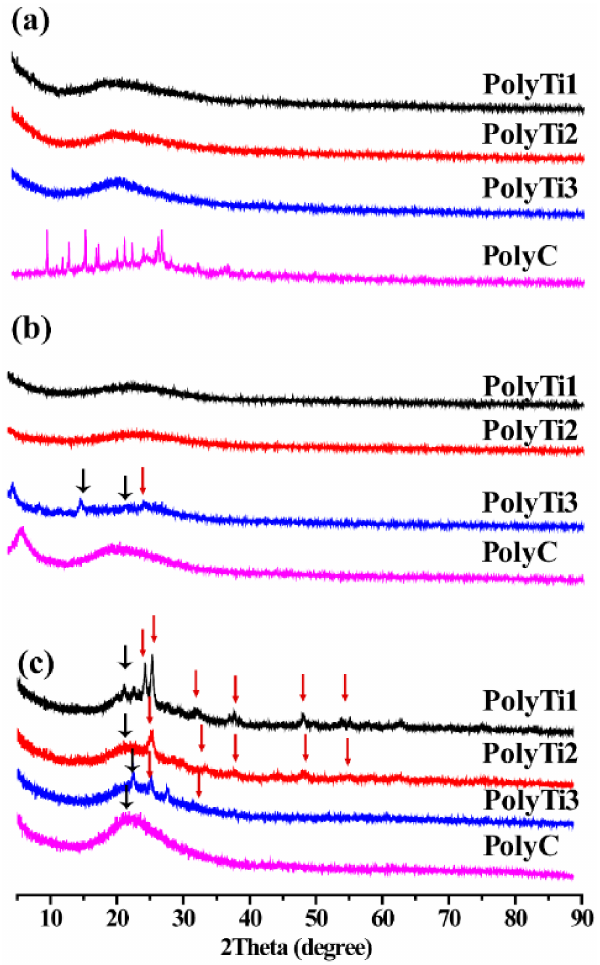
Figure 7. XRD spectra of PolyTi and PolyC: ( a ) unsintered, ( b ) sintered residue at 400 ◦ C, and ( c ) sintered residue at 800 ◦